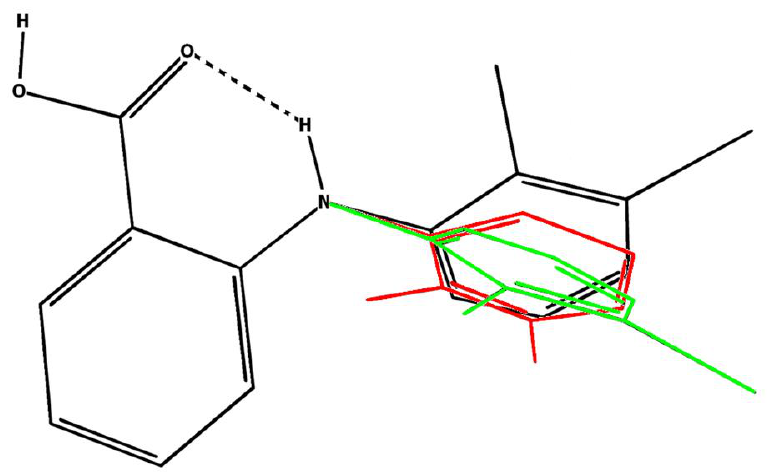
Figure 3. Structure of the MFA conformers present in polymorphic forms I (black) [49], II (red) [28], and III (green) [46].